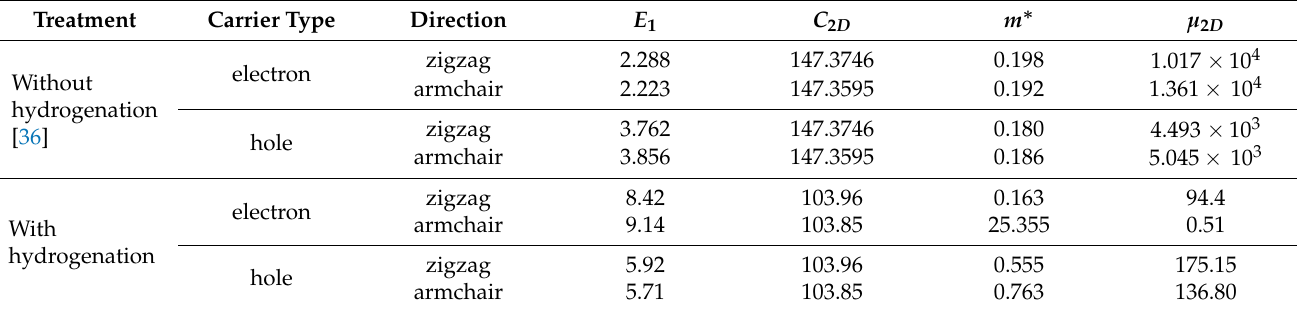
Table 1. Calculated carrier mobility ( µ 2 D , cm 2 · V − 1 · s − 1 , deformation potential constant ( E 1 , eV), in-plane stretching modulus ( C 2 D ,cJ/m 2 ), and effective mass ( m ∗ , m e is the electron mass) in BP monolayer without and with hydrogen passivation along zigzag and armchair directions at 300